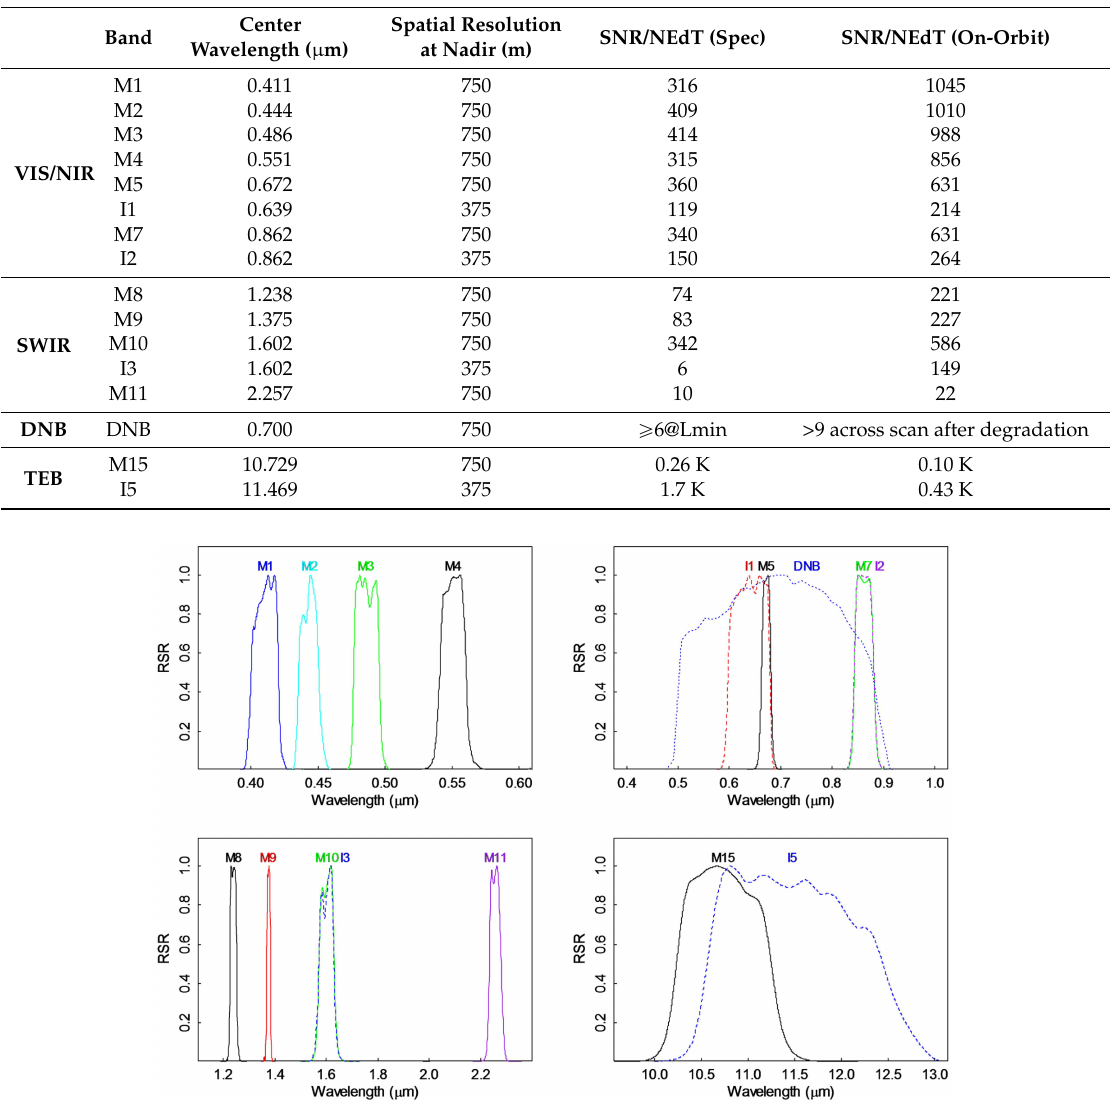
Table 1. Spectral, spatial, and radiometric characteristics of Visible and Infrared Imaging Radiometer Suite (VIIRS) spectral bands used in this study. M1–M5 and M7 SNRs at low gain stage and typical scene radiances are listed because Deep Convective Clouds (DCCs) are highly reflective; band M15 and I5 NEdTs is estimated at 205 K scene temperature.